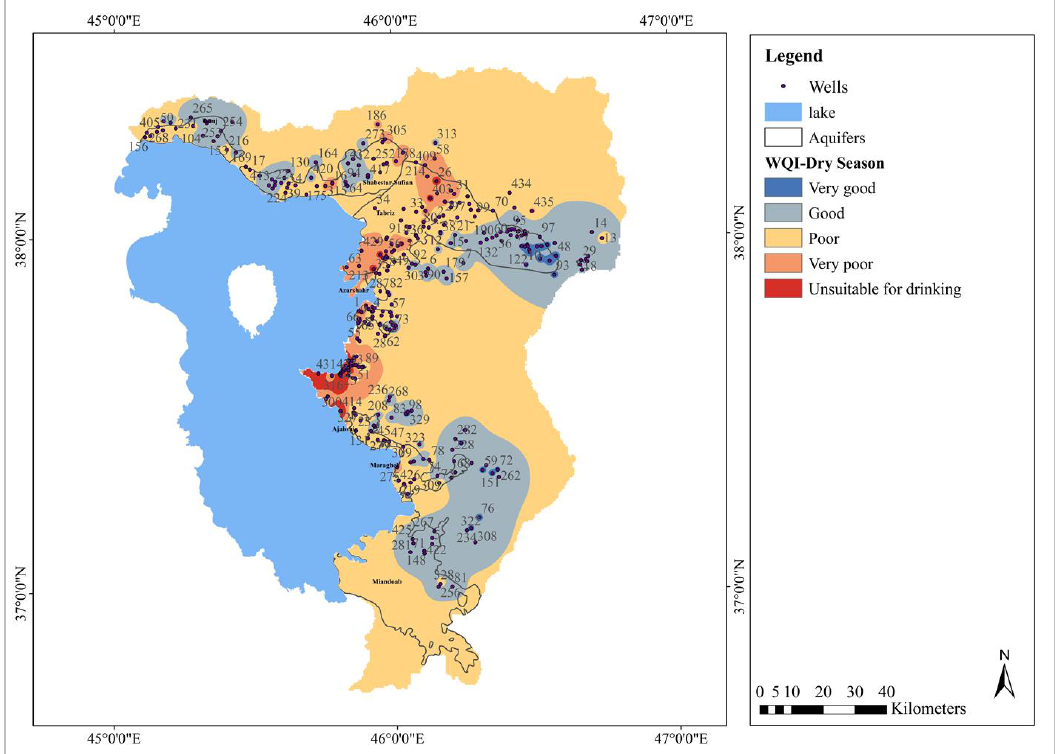
Figure 6. Water quality status in the aquifers of the study area.